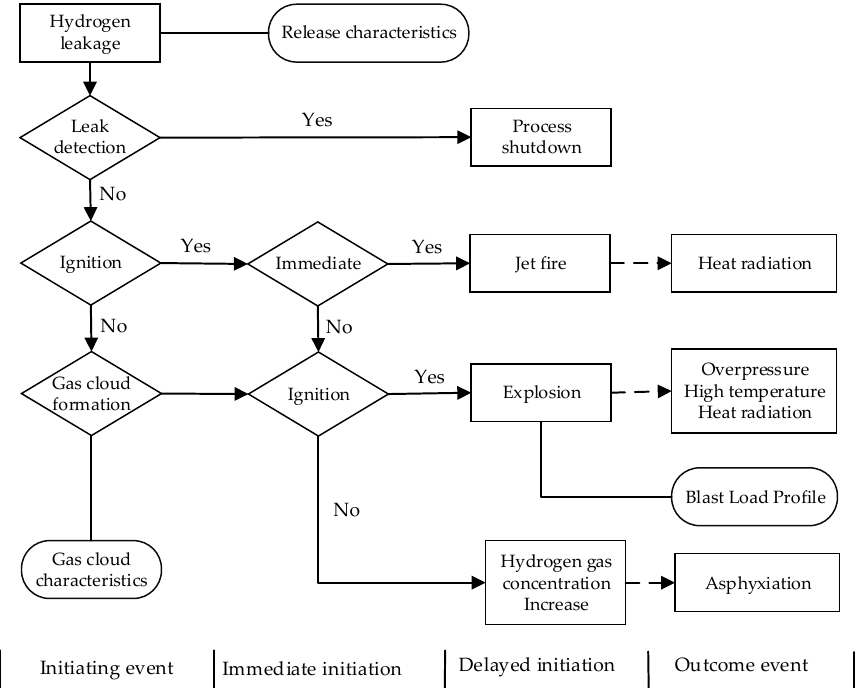
Figure 1. Hydrogen leakage event tree in enclosed space or confined space.